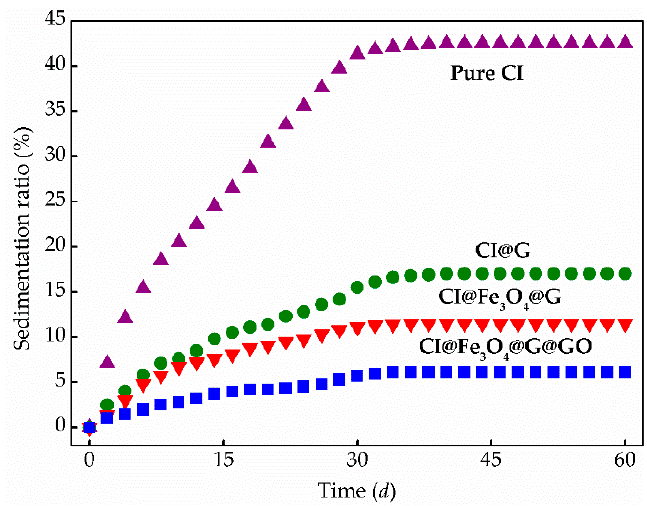
Figure 10. Sedimentation profile recorded as a function of time for MR fluids based on pure CI, CI@G, CI@Fe 3 O 4 @G, and CI@Fe 3 O 4 @G@GO particles.